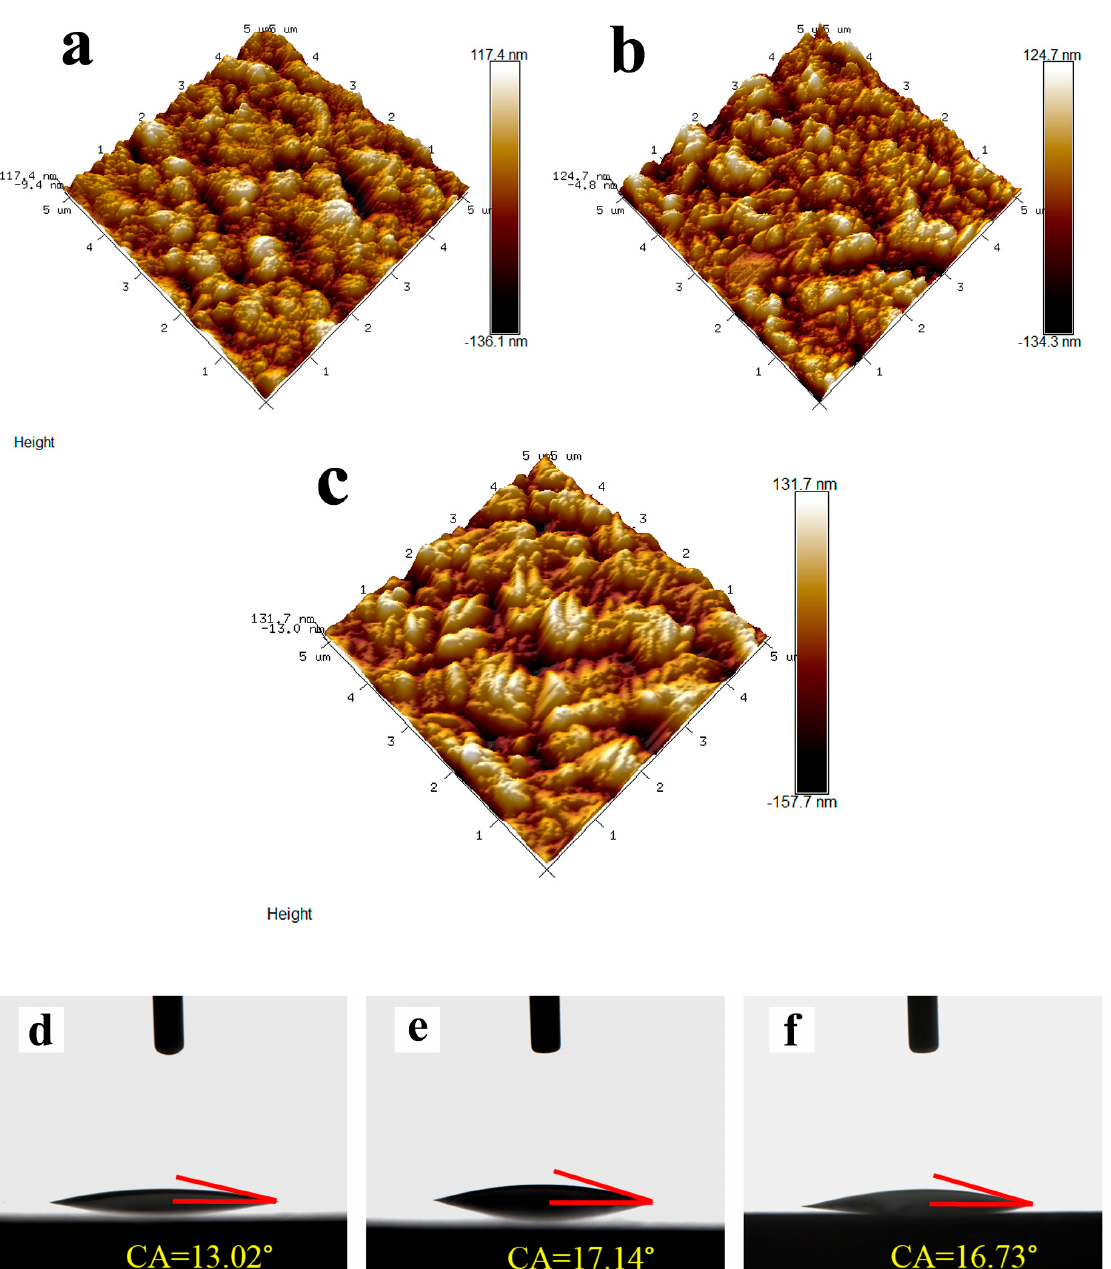
Figure 6. AFM micrographs and contact angles of the anatase coatings: ( a , d ) MgZn–0.1 F; ( b , e ) MgZn–0.2 F; ( c , f ) MgZn–0.3 F.